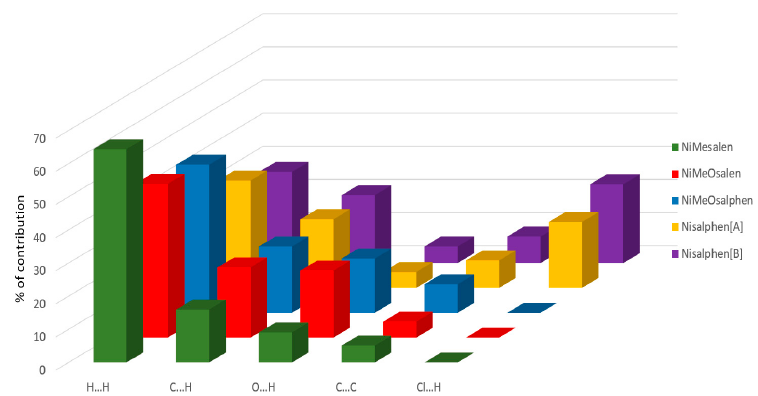
Figure 11. Contribution of some intermolecular contacts for HS of the compounds NiMe salen , NiMeO salen , and NiMeO salphen, as well as for molecules A and B of compound Ni salphen.